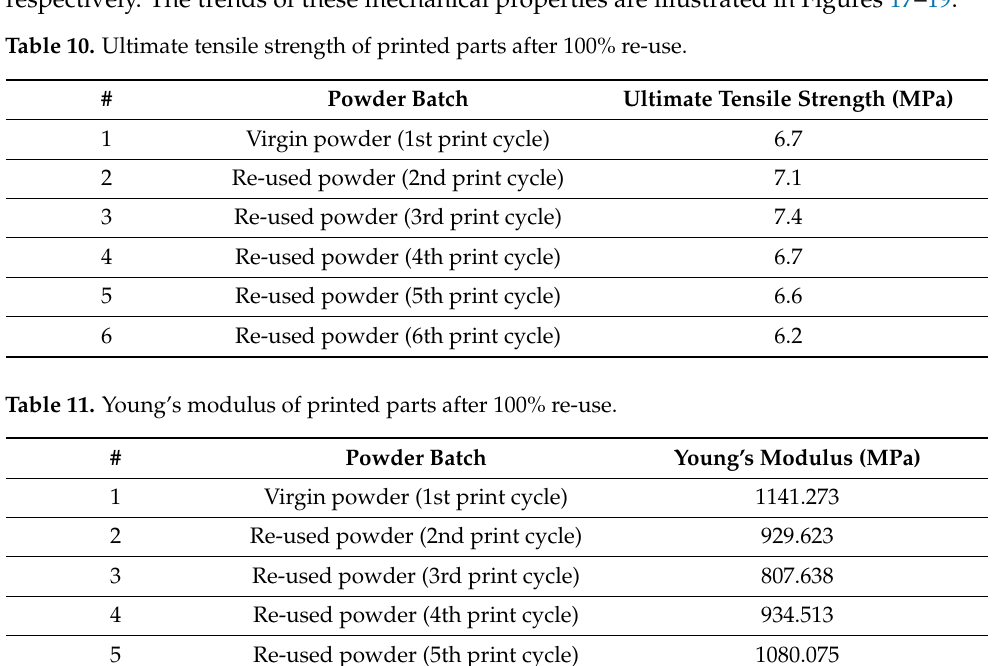
Table 10. Ultimate tensile strength of printed parts after 100% re-use.